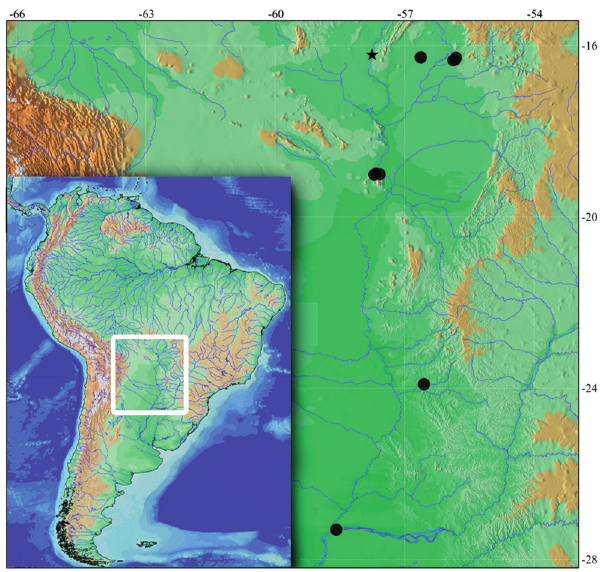
Fig. 3. Geographic distribution of Ochmacanthus batrachostoma (black star, holotype; black circle, non-type